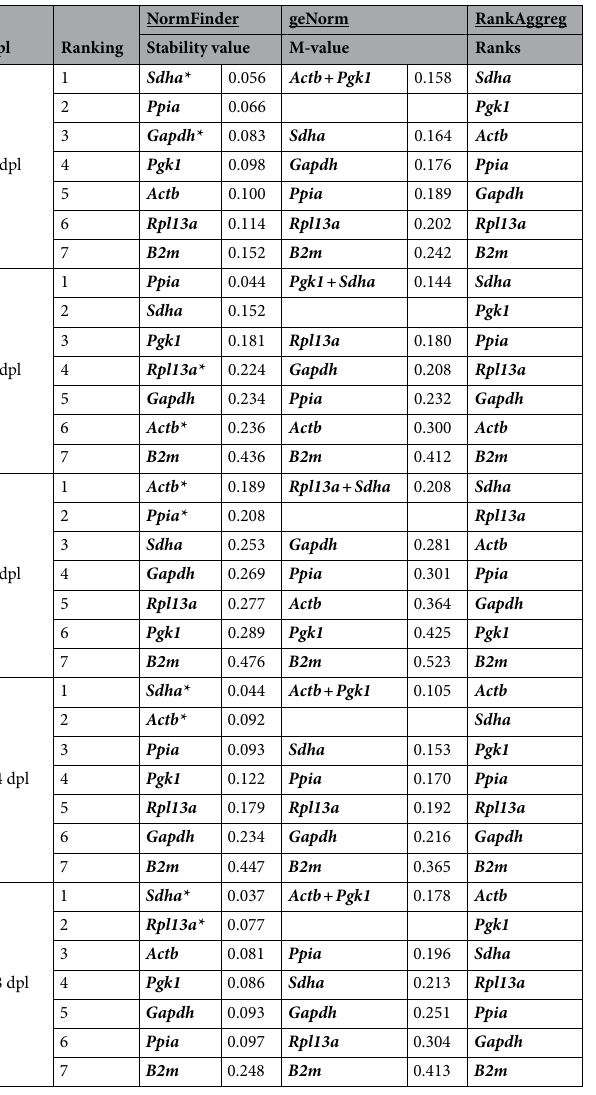
Table 2. Ranking of candidate reference genes according to their expression stability for the outer molecular layer after entorhinal denervation. Candidate reference genes were ranked according to their stability values by NormFinder, averaged expression by geNorm and using a consensus ranking analysis by RankAggreg for the outer molecular layer at specific time-points after entorhinal denervation. Asterisks (left column) indicate the genes selected as ‘best combination of two RGs’ by